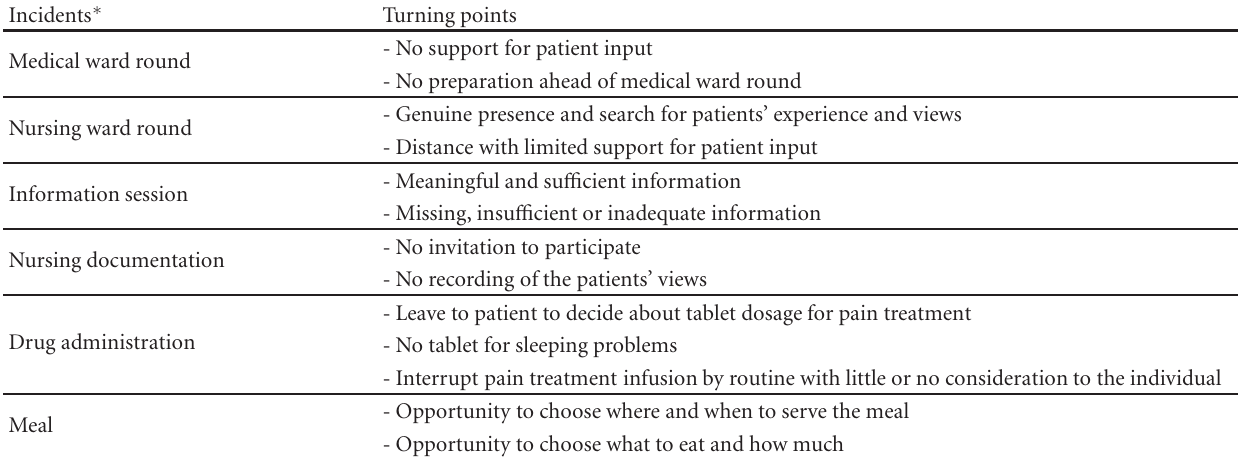
Table 1: Incidents and turning points based on patients’ narratives of critical incidents.